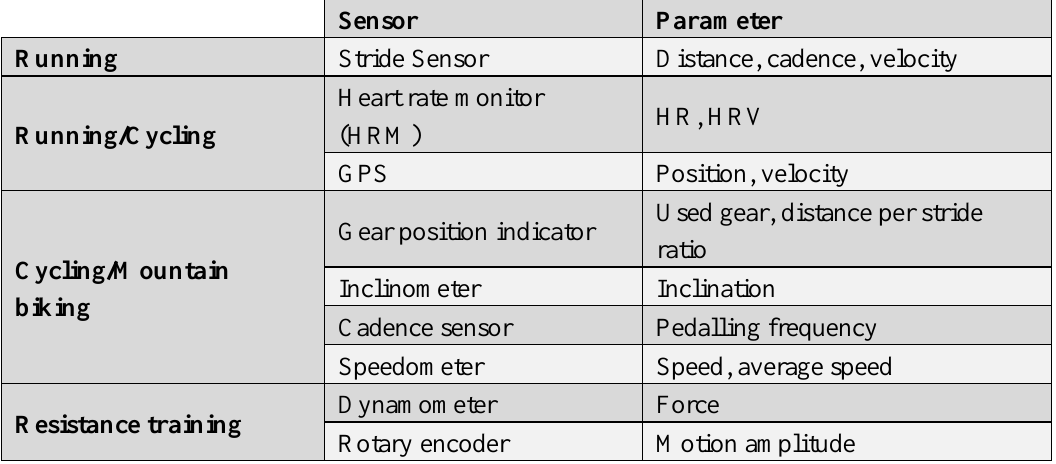
Table 5. Parameter/sensor combination in selected sports.